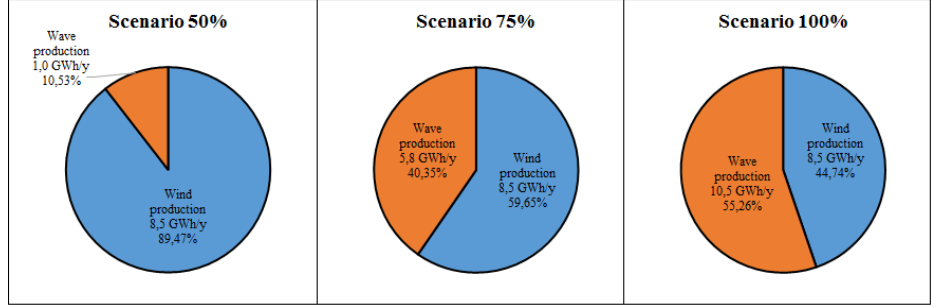
Figure 8. Scenarios of total electrical energy request (produce and store H 2 ) satisfied by renewable energies (wind and sea wave). Table 4. Electrical energy production from wind and wave sources.